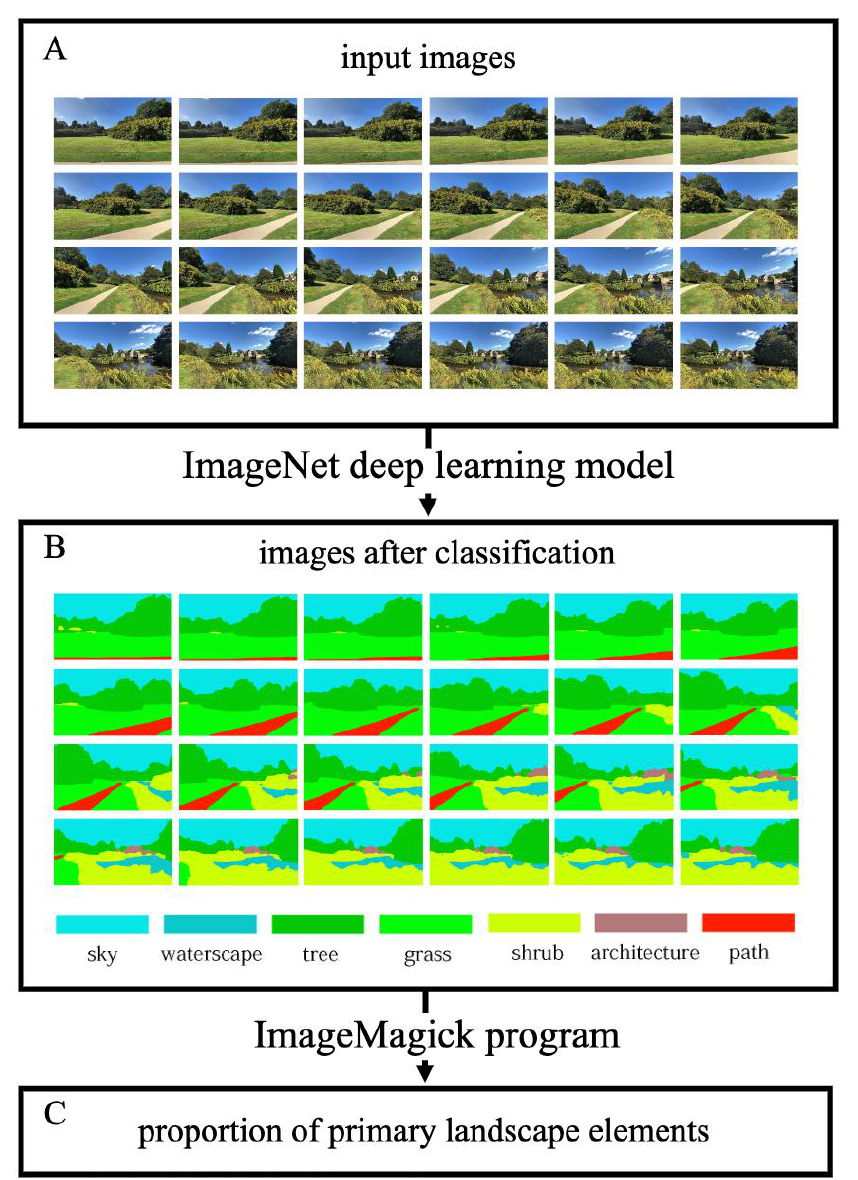
Figure 3. An example of how dominant landscape elements can be extracted along with their proportional data from a scene. Use C15 as an illustration and sample once every second. First, ( A ) frame images are given to the ImageNet deep learning model. Second, ( B ) acquire the classified pictures. Third, count the number of pixels in each class using the ImageMagick program, and ( C ) obtain the proportion information.